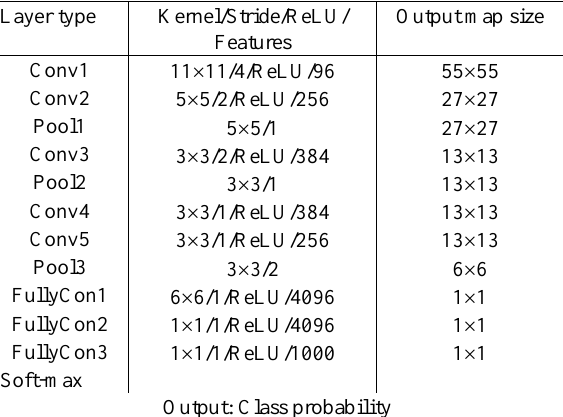
Table 1. Architecture of AlexNet